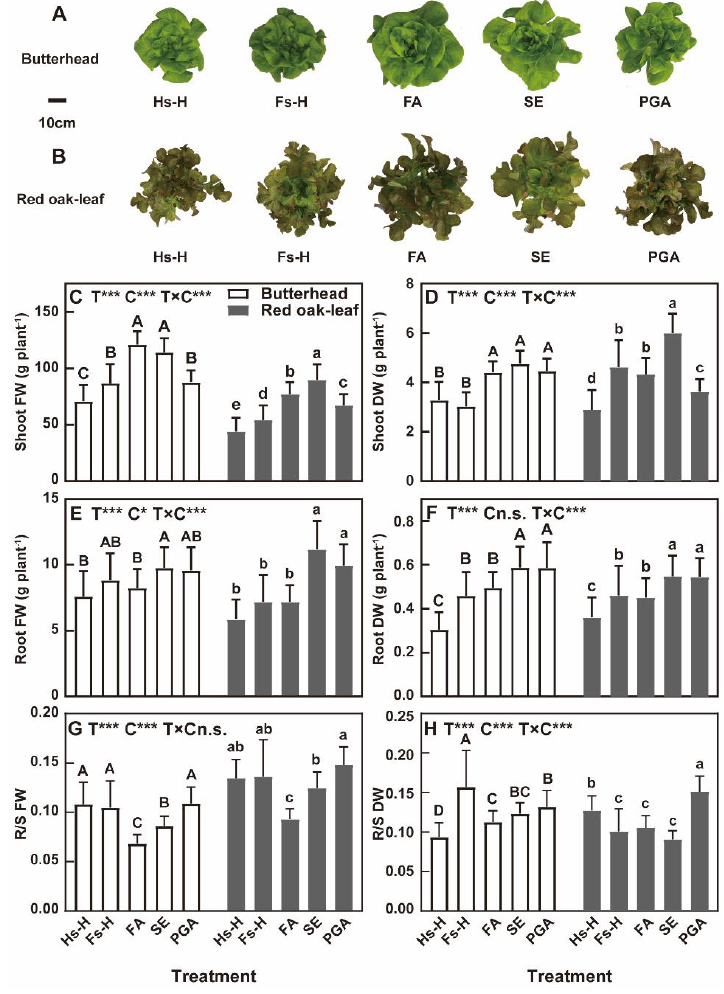
Figure 1. ( A , B ) Growth status, ( C , D ) fresh weight (FW) and dry weight (DW) of shoot, ( E , F ) FW and DW of root, and ( G , H ) root-to-shoot (R/S) ratio by nutrient solution treatments and lettuce cultivars. Data represent mean ± standard deviation (SD) ( n = 30). Different upper- and lowercase letters indicate significant differences among nutrient solution treatments for butterhead and red oak-leaf, respectively (α = 0.05). T — main effect of treatment; C — main effect of cultivar; T × C — treatment by cultivar interaction. *, ** and *** indicate significant difference at α = 0.05, 0.01, and 0.001, respectively; n.s. indicates not significant.